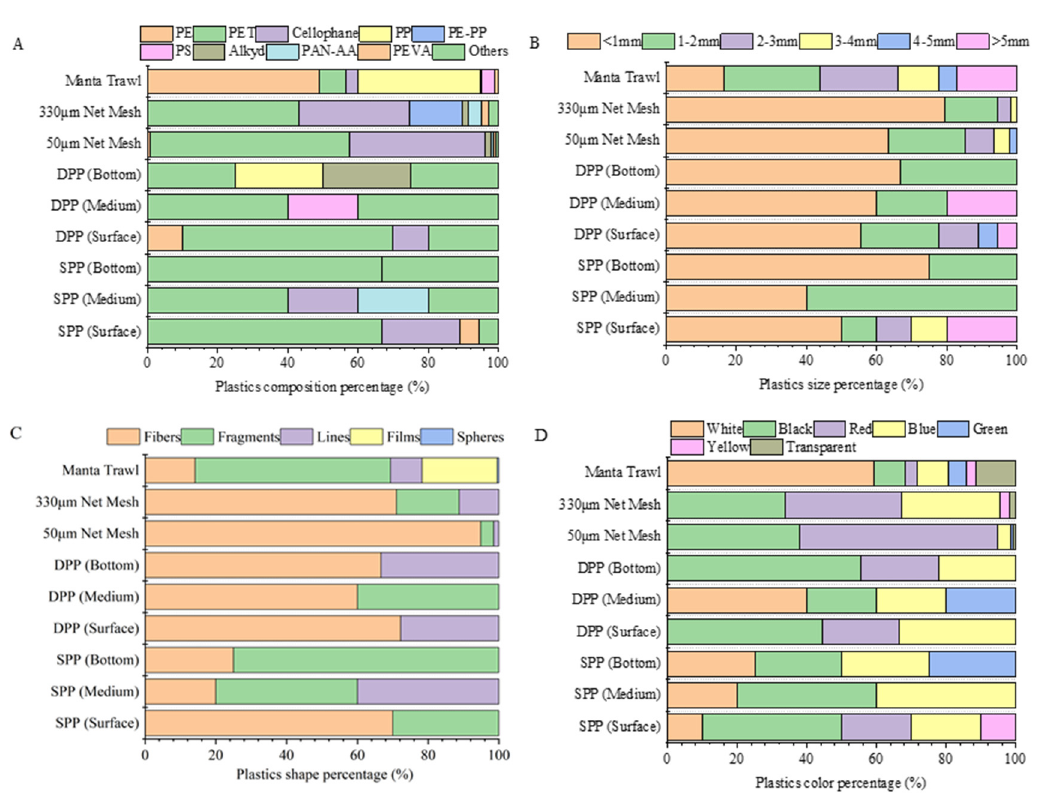
Figure 3. The percentage distribution of chemical composition ( A ), size ( B ), shape ( C ), and color ( D ) of plastic and microplastic samples collected by 4 sampling methods. SPP represented shallow-water plankton pump; DPP represented deep-water plankton pump